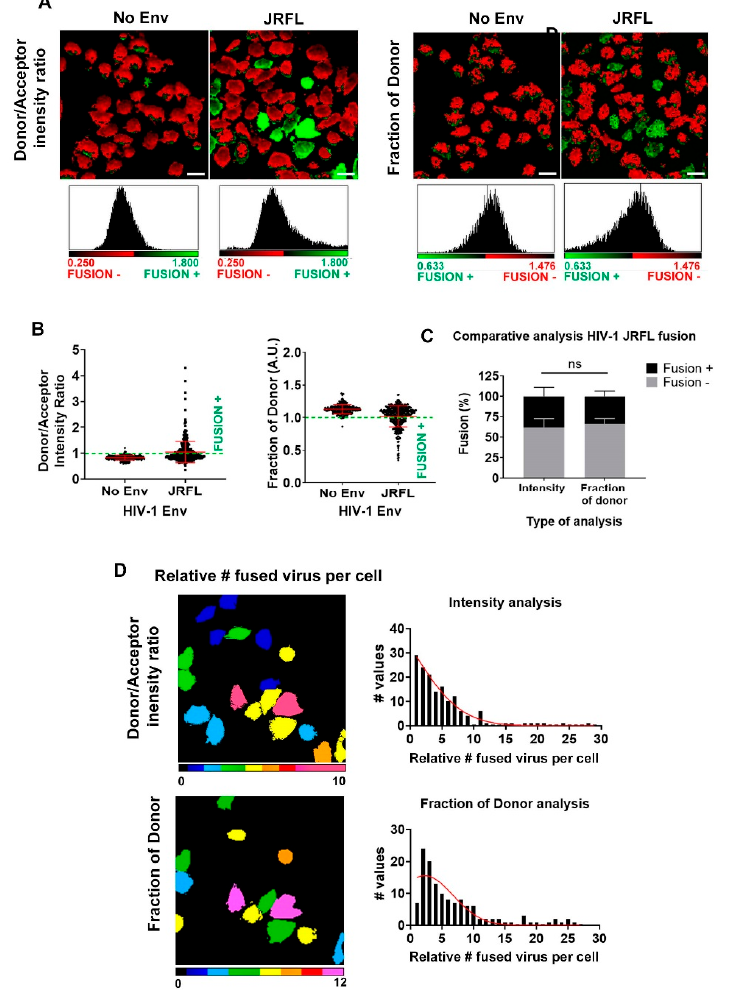
Figure 3. BlaM HIV-1 fusion quantification per cell in TZM-bl cells. ( A ) Micrographs for a population of TZM-bl cells exposed to HIV-1 JFRL virions (MOI = 5) and their corresponding